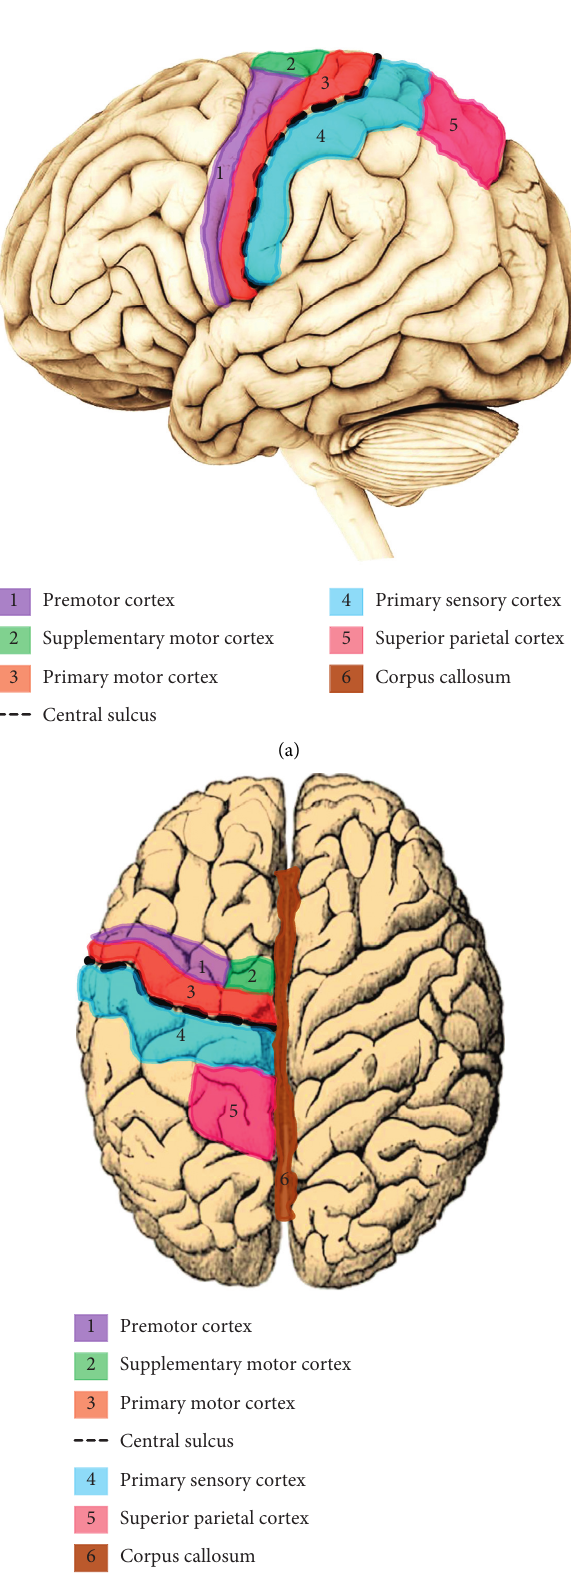
Figure 1: (a, b) The cortex seen from two different aspects showing parts of the brain involved in fine motor movement (modified from